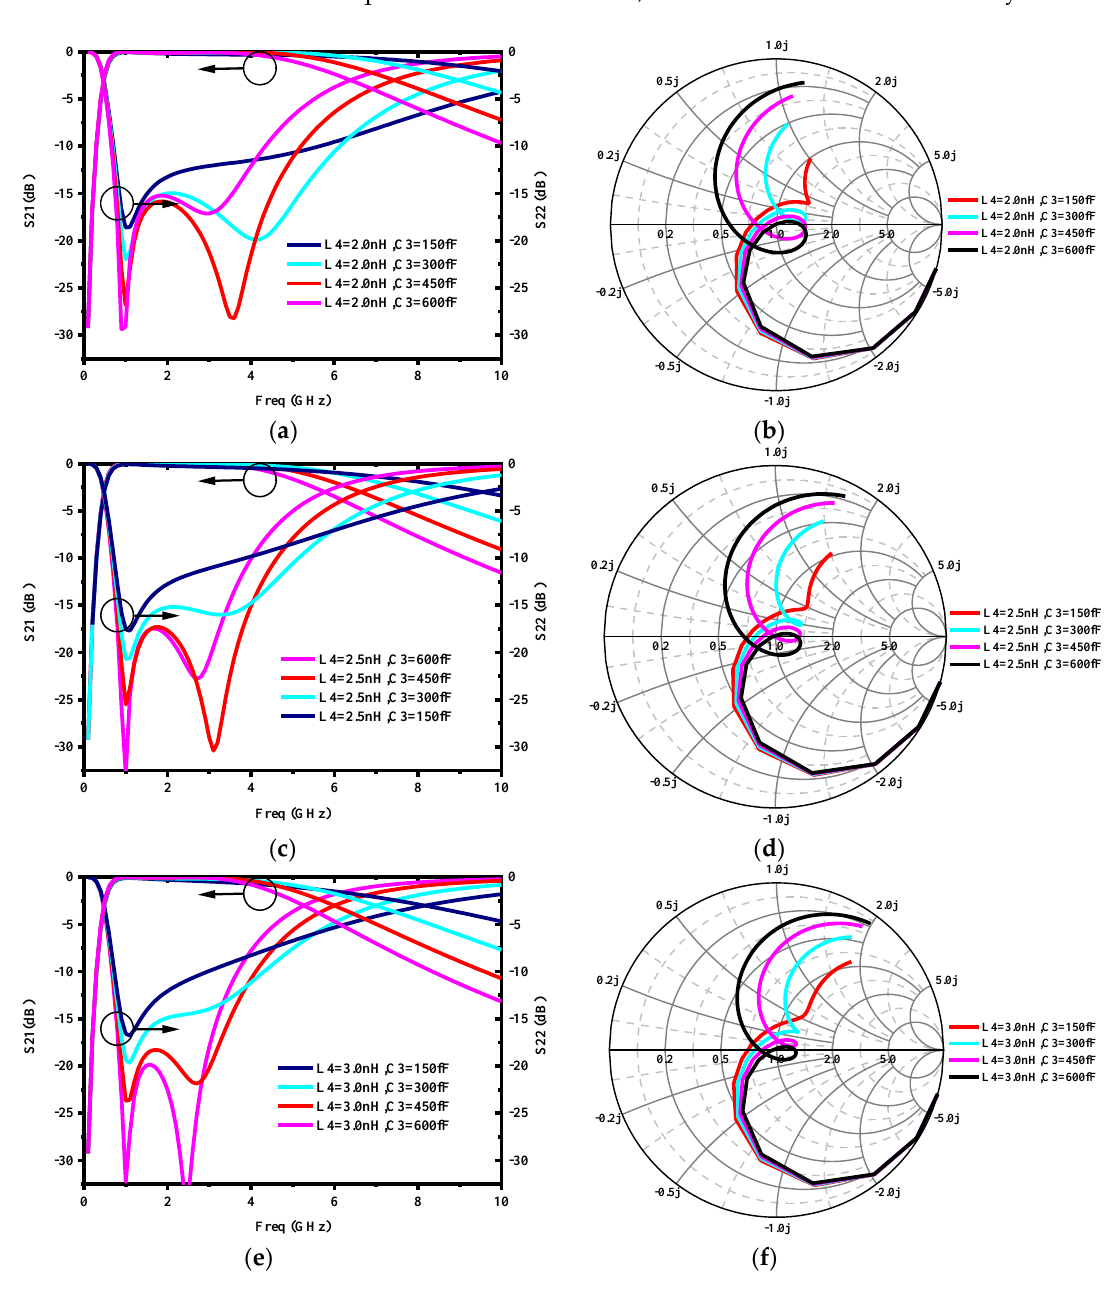
Figure 7. Performance of different combinations of capacitor C 3 and inductance L 4 : ( a ) S-Parameters for L 4 = 2 nH; ( b ) Impedance trace of ( a ); ( c ) S-Parameters for L 4 = 2.5 nH; ( d ) Impedance trace of ( c ); ( e ) S-Parameters for L 4 = 3 nH; ( f ) Impedance trace of ( e ). Finally, according to the compromise of each index, the values of each component of the proposed LNA are shown in Table 1. Table 1. Values of components in circuit.